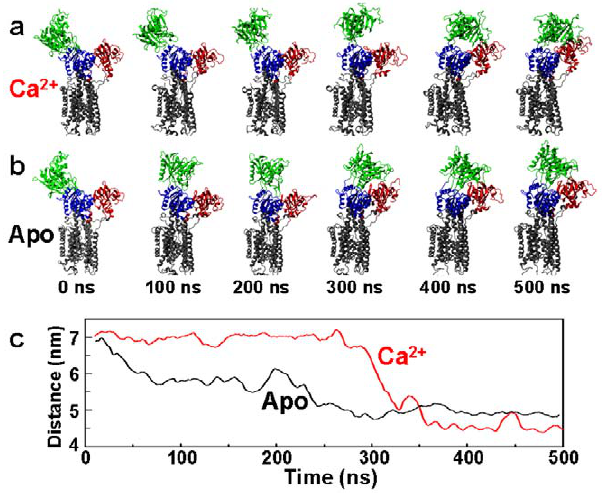
Figure 2. Time-dependent conformational transitions of SERCA. Structural snapshots from the simulations of Ca 2 + -bound (a) and Apo (b) SERCA, showing a complete transition from the open conformation (green N domain and red A domain far apart at 0 ns) to a closed one within 400 ns. (c) C a -C a distance between residues Met1 (A domain) and Lys515 (N domain) of Apo ( black ) and Ca 2 + -bound ( red ) SERCA.